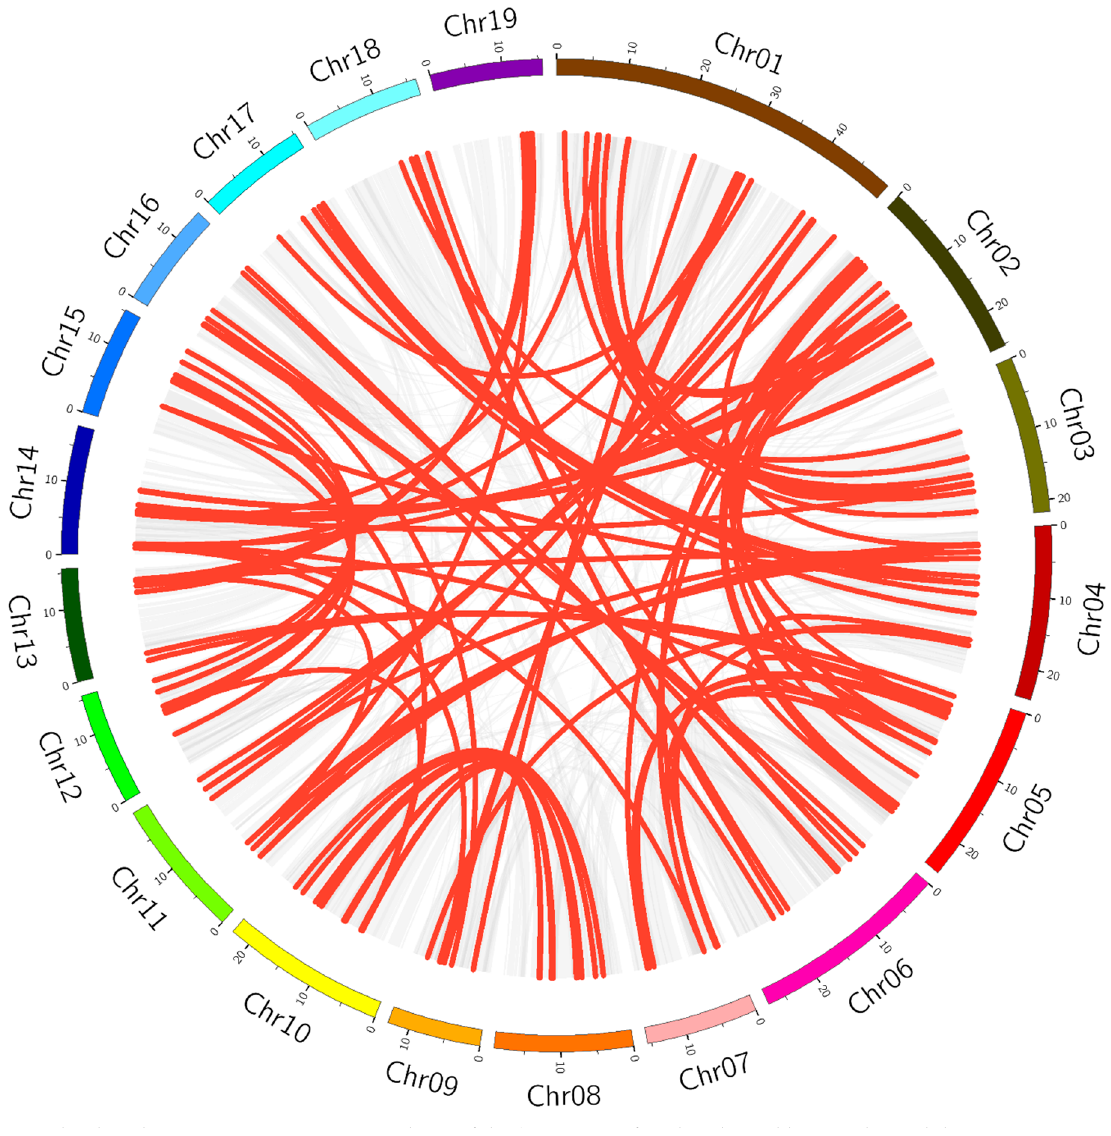
Figure 2. The distribution pattern synteny analysis of the bHLH gene family. The red lines indicated the synteny gene pairs of the bHLH gene family. Scale bar marked on the chromosome indicates chromosome lengths (Mb). Chr: Chromosome.